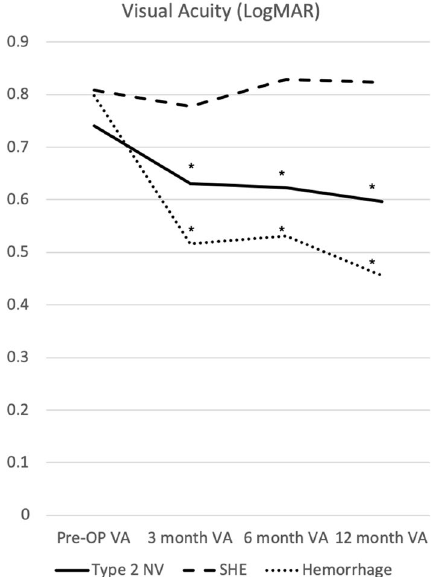
Figure 2. Visual acuity according to different SHRM types after 1 year of treatment. *p < 0.05 compared with baseline visual acuity. SHRM subretinal hyperreflective material, OP operation, VA visual acuity, NV neovascularization, SHE subretinal hyperreflective